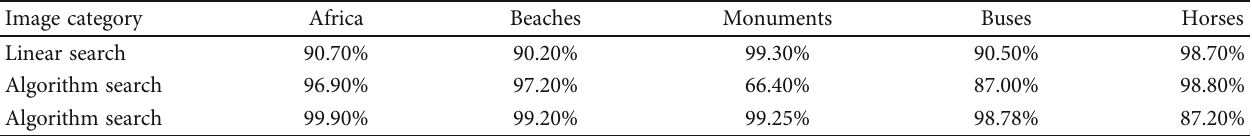
Table 2: Comparison of the average corresponding time of the two search methods.